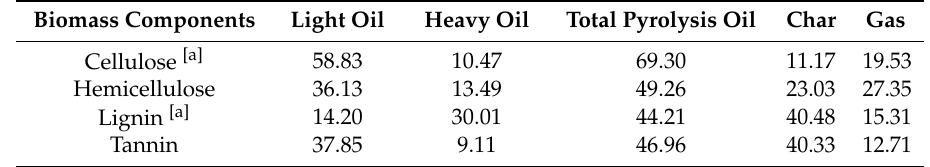
Table 2. Yields of light oil, heavy oil, char, and gas for the pyrolysis of cellulose, hemicellulose, lignin, and tannin at 600 ◦ C.